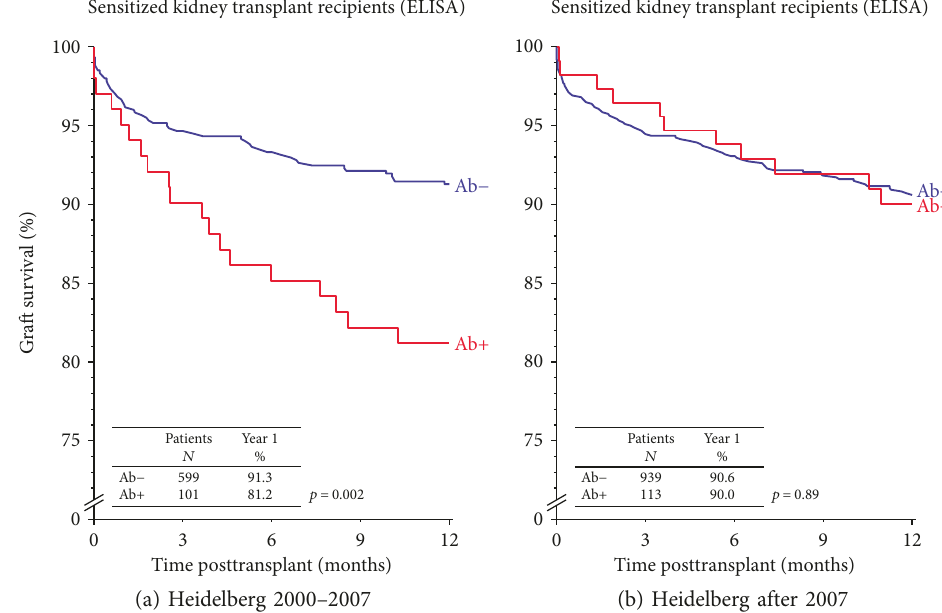
Figure 1: Graft survival in patients with and without ELISA-reactive HLA antibodies who were transplanted at the Heidelberg Transplant Center between 2000 and 2007 (a) and after 2007 (b). Ab: ELISA-reactive HLA